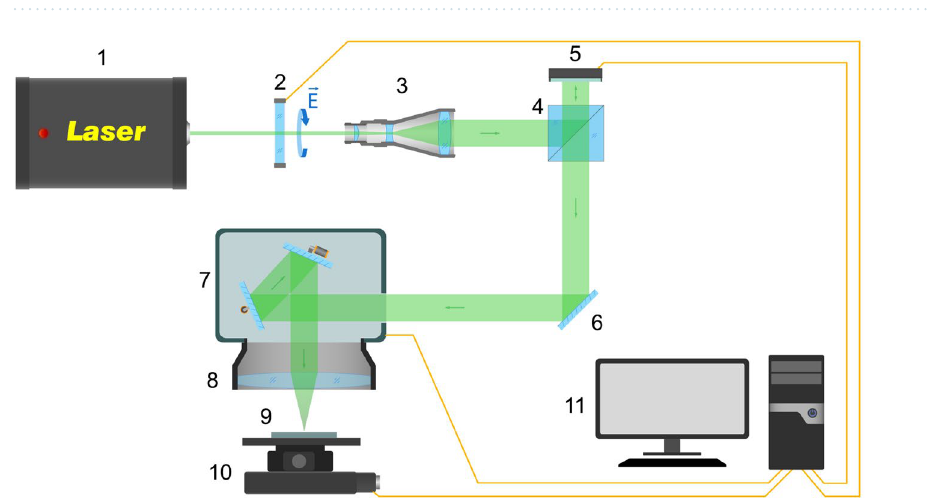
Figure 4. SEM images of different parts of the hologram: ( a ) high brightness; ( b ) intermediate level of brightness; ( c ) low brightness. Insets I–VI denote DLOA for various segments of quasihologram.